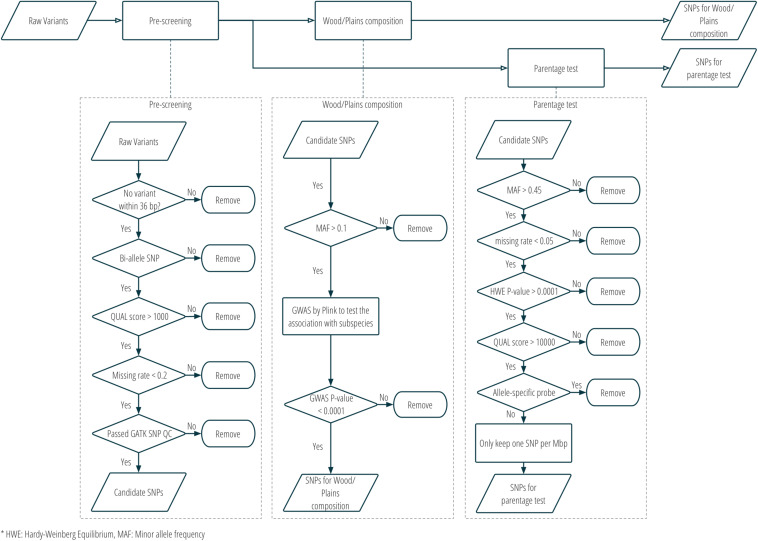
SNP selection procedure for the custom panel for parentage and subspecies composition analysis.